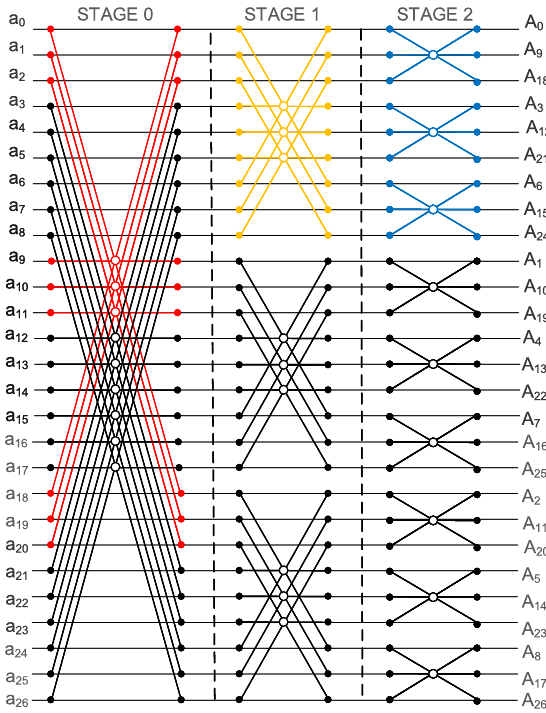
Figure 14: The dataflow of 27-point radix-3 DIT-NR NTT with d =